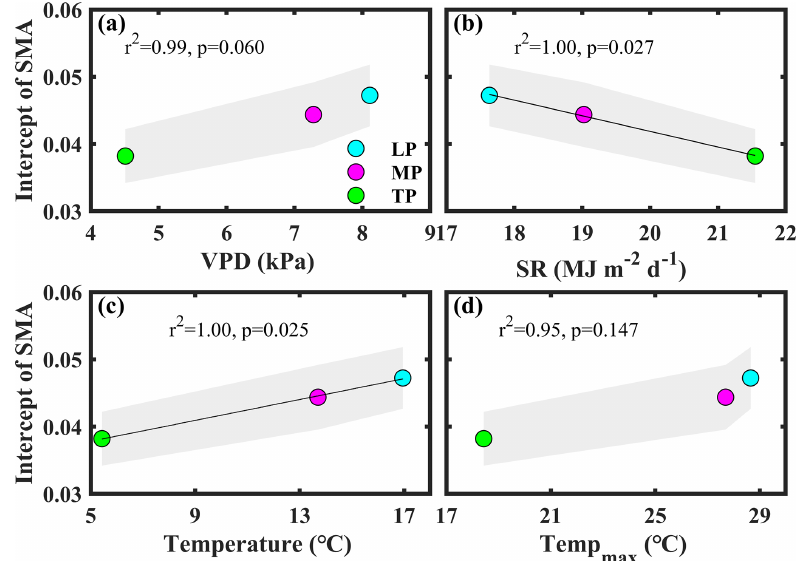
Figure 3. Patterns of the intercept obtained from standardized major axis (SMA) analysis among transects. The variables mentioned in the figure are as follows: VPD – vapor pressure deficit, SR – solar radiation, and Temp max – maximum temperature. LP represents the Loess Plateau, MP represents the Inner Mongolian Plateau, and TP represents the Tibetan Plateau. The shaded area represents the 95% confidence interval of the SMA